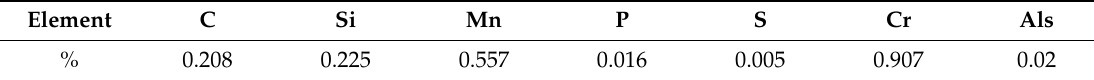
Table 1. The main chemical composition of the experimental steel in the trial, wt %. Element